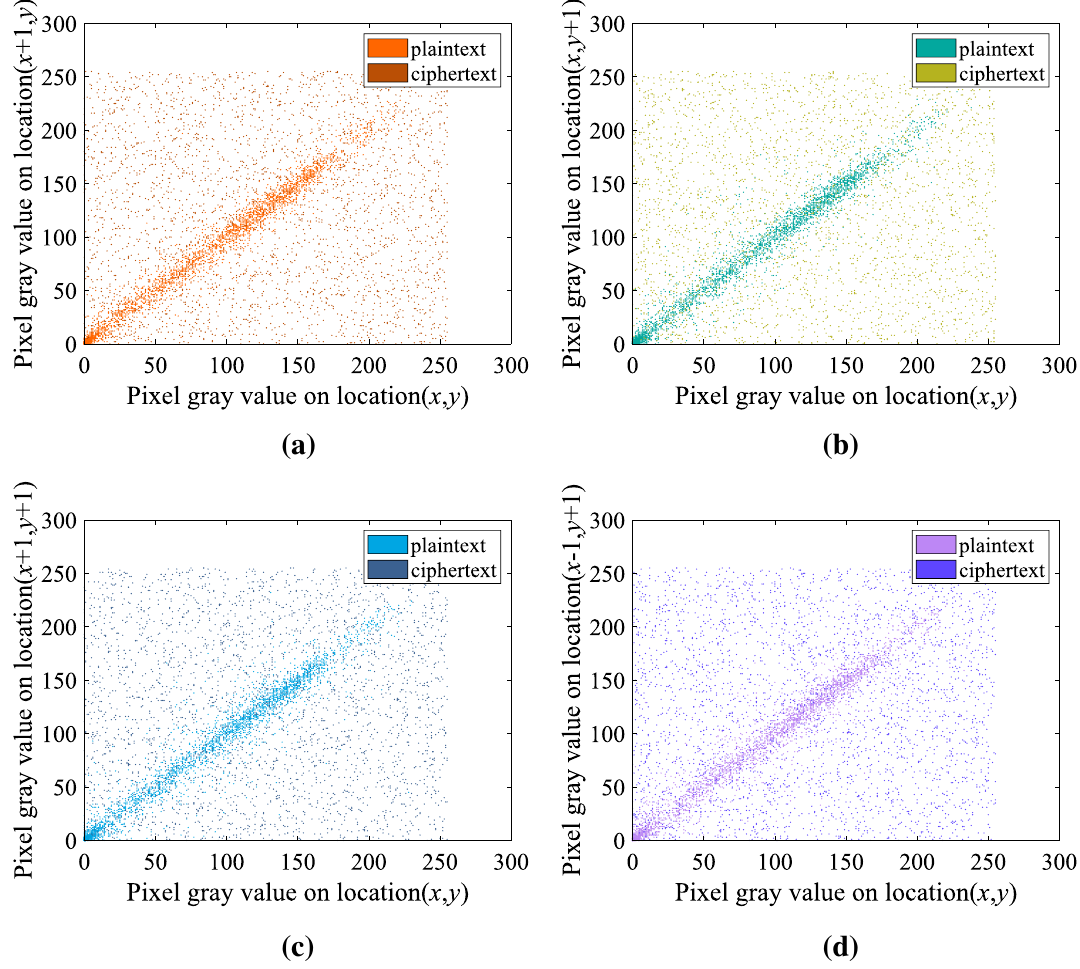
Figure 12. Correlation coefficients distribution map of plain image and cipher image of 5.2.10.tiff ( a ) horizontal correlation; ( b ) vertically correlation; ( c ) diagonal correlation; ( d ) against angular direction